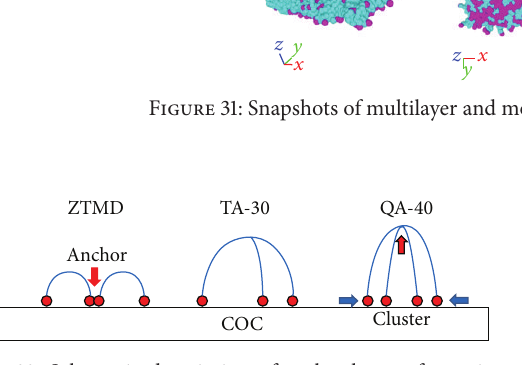
Figure 32: Schematic description of molecular conformations of ZTMD, TA-30, and QA-40 on